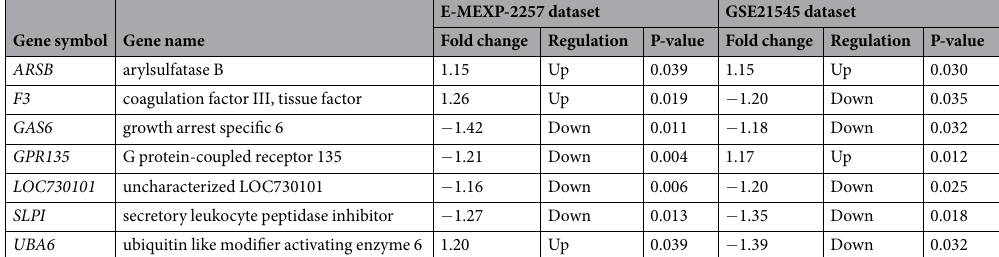
Table 2. Genes for which the expression in carotid atherosclerosis was consistently associated with the symptoms of cerebral embolization in the two microarray datasets included in this study. P-value, calculated with non-parametric Mann-Whitney test without mathematical correction for multiple comparisons.